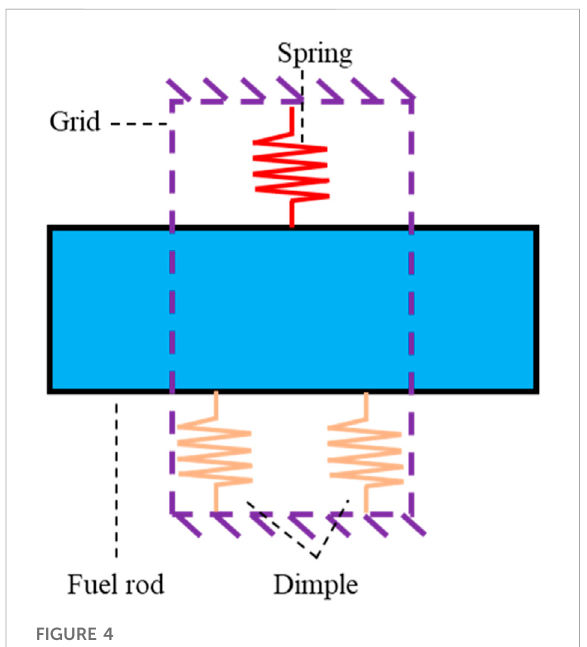
FIGURE 4 Schematic diagram of elastic